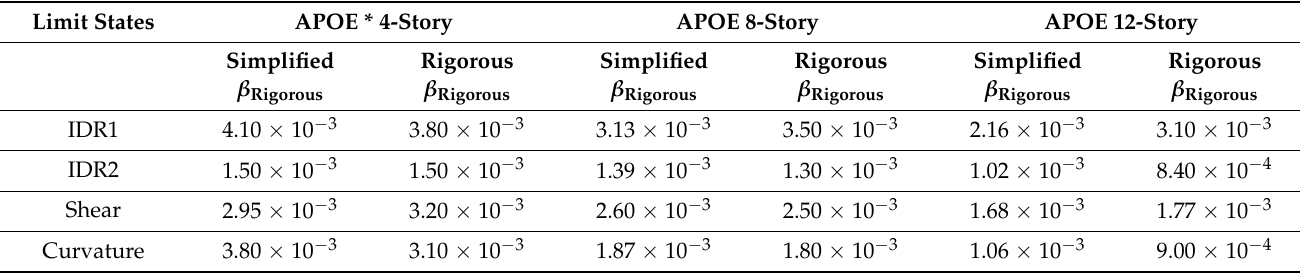
Table 8. Annual probability of exceeding limit states for the case study buildings obtained through rigorous multi-stripe analyses and via the simplified approach using rigorous (numerically found) values of total